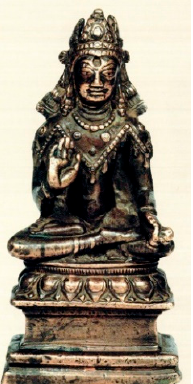
Figure 14. Buddha wearing a crown and a jeweled cape, seventh to eighth c.Kashmir. Brass with silver inlay. H 16 cm. Jo khang/gTsug lag khang Collection; inventory no. 644, Lhasa, Tibet. https: